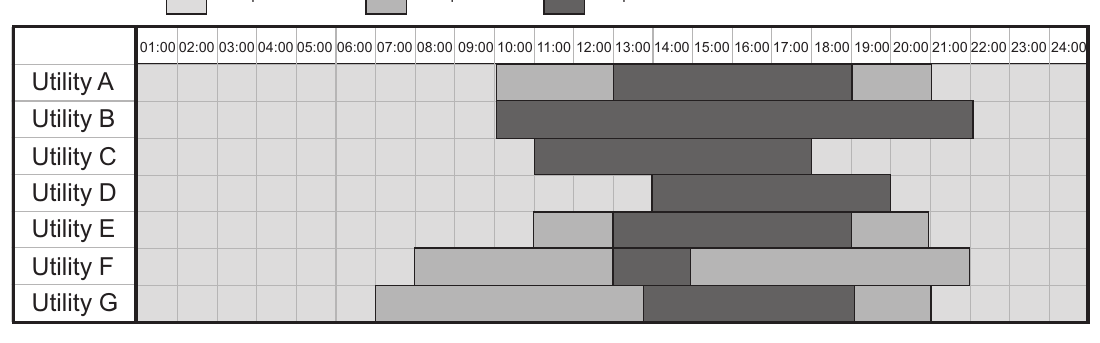
Table 5. Time of use